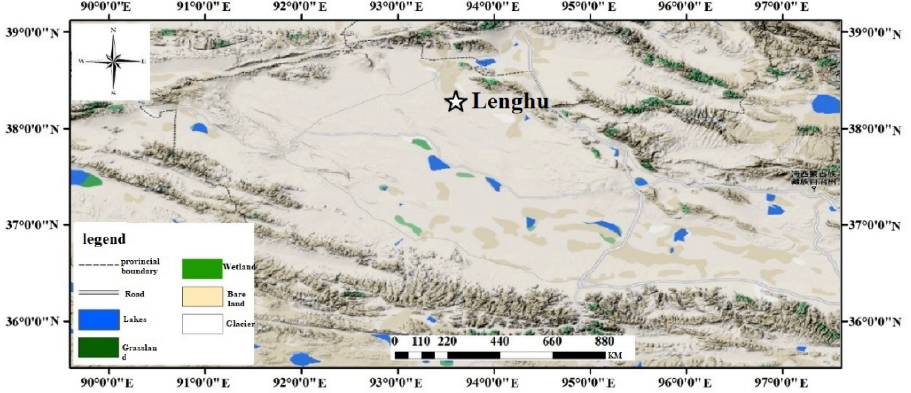
Fig. 1. Sketch map of study area